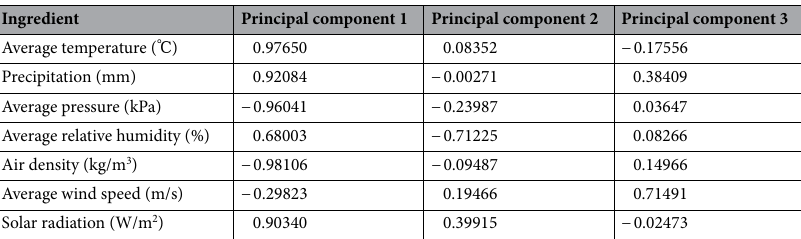
Table 3. Principal component analysis load matrix of meteorological elements in Hancang river basin.